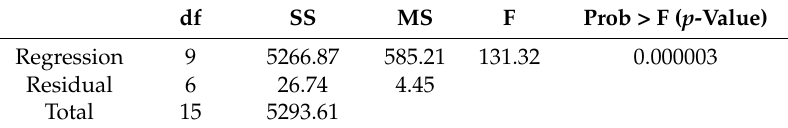
Table 4. Analysis of variance (ANOVA) of the quadratic polynomial model.